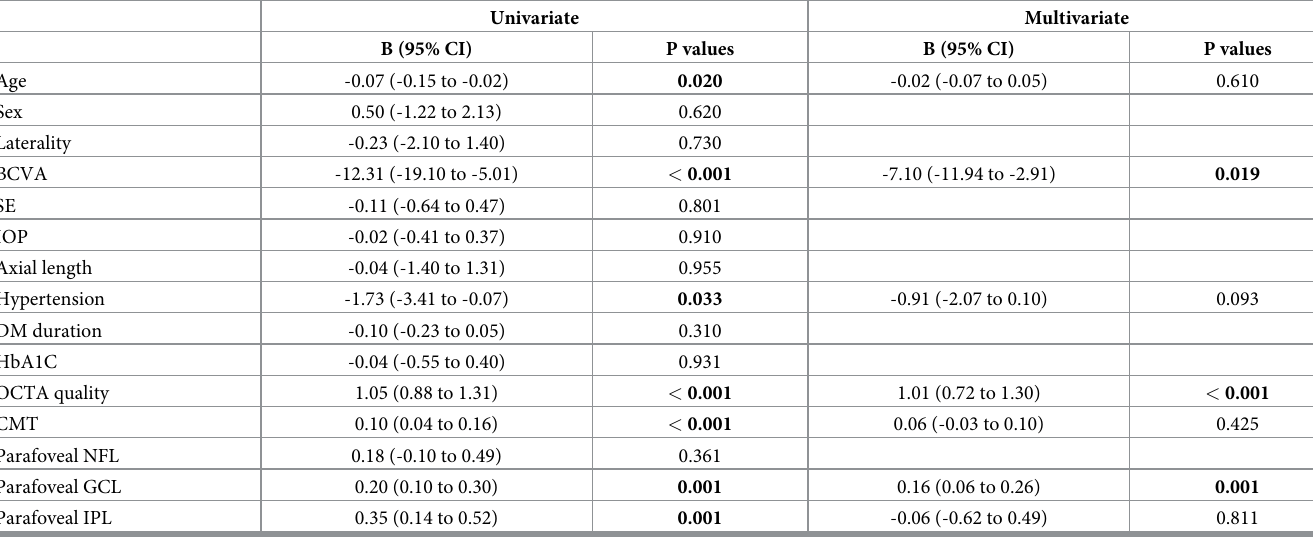
Table 3. Univariate and multivariate linear regression analyses determining factors associated with vessel density of superficial capillary plexus in patients with type 2 diabetes. Univariate Multivariate B (95% CI) P values B (95% CI) P